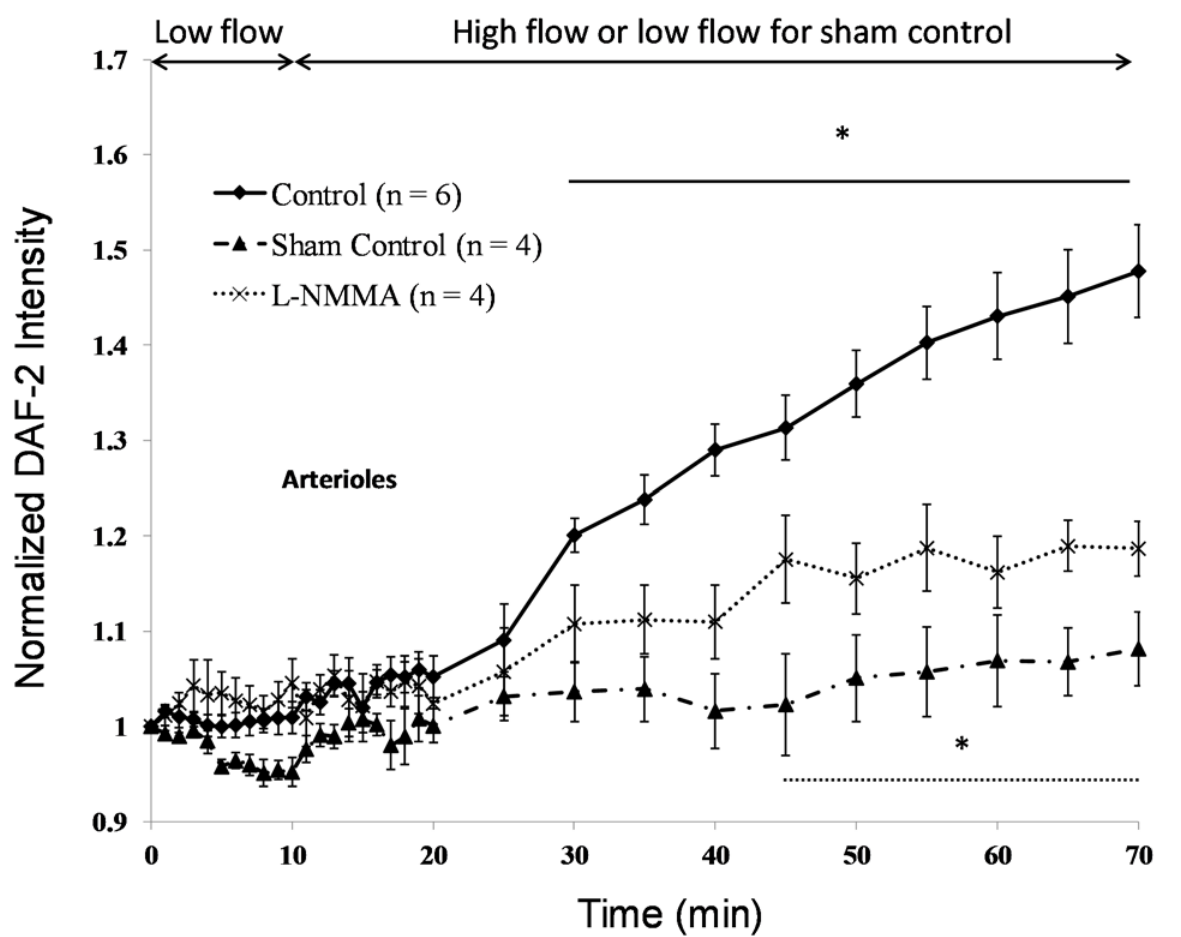
Figure 6. Flow-induced increases in NO production (DAF-2 intensity normalized by that after 45min DAF-2 DA loading) under various conditions in arterioles. The solid line with diamonds is for the control of perfusing 1% BSA-Ringer under the low flow (~300 μ m/s) for 10 min and the high flow (~2000 – 2500 μ m/s) for 60 min; the dash-dot-dash line with triangles is for the sham control of perfusing 1% BSA-Ringer under the low flow for 70 min; and the dotted line with crosses is for that in the presence of L-NMMA. * p < 0.05 compared with that at 10 min low flow (for the control and L-NMMA